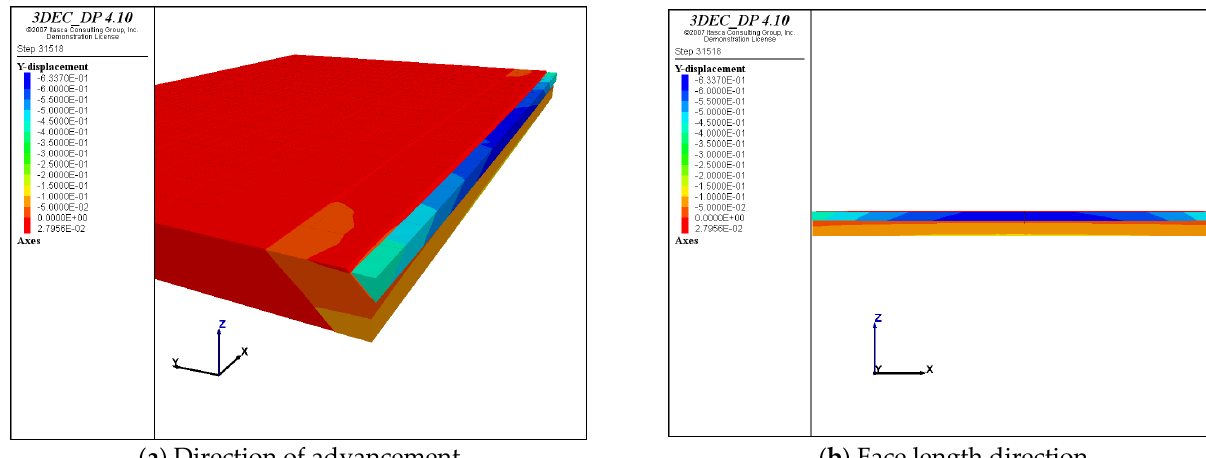
Figure 14. Y-displacement nephogram ( α = 45°).